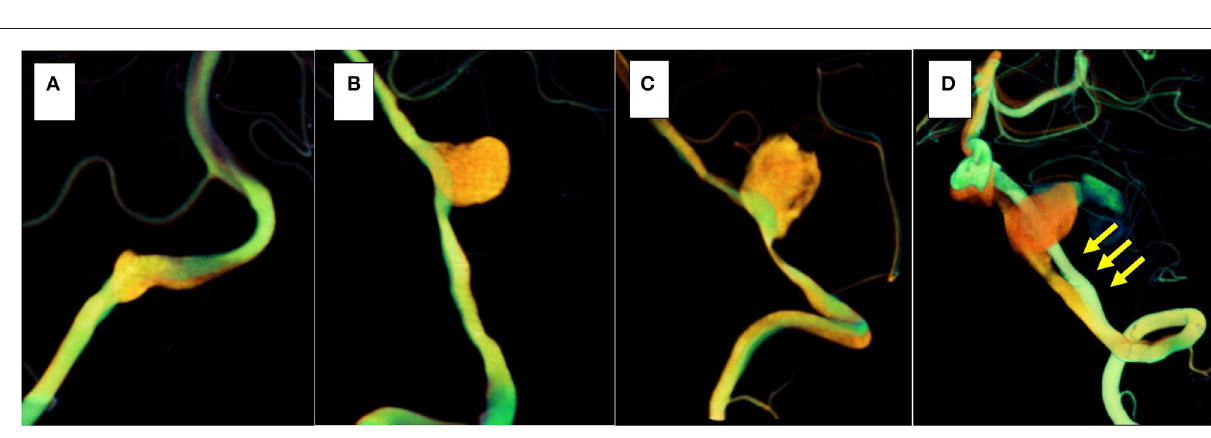
FIGURE 6 | The orange vessel is pre-treatment, and the green vessel is post-treatment. In three cases (cases 1–3), morphological changes in the stented parent artery were not seen (A–C) ; however, in the recurrent case (case 4), the parent artery straightened after stent placement (yellow arrows) (D)